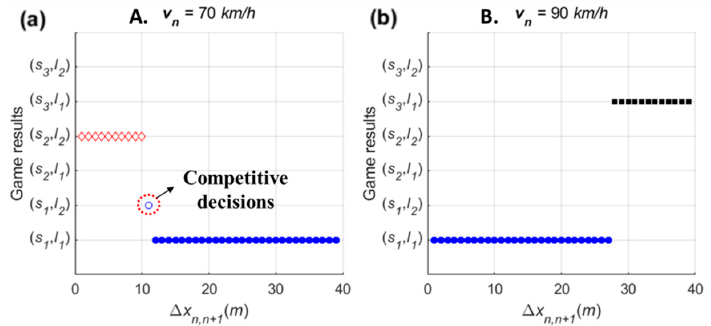
/ h; ( b ) ∆ v / n = 70 km n = 90 km